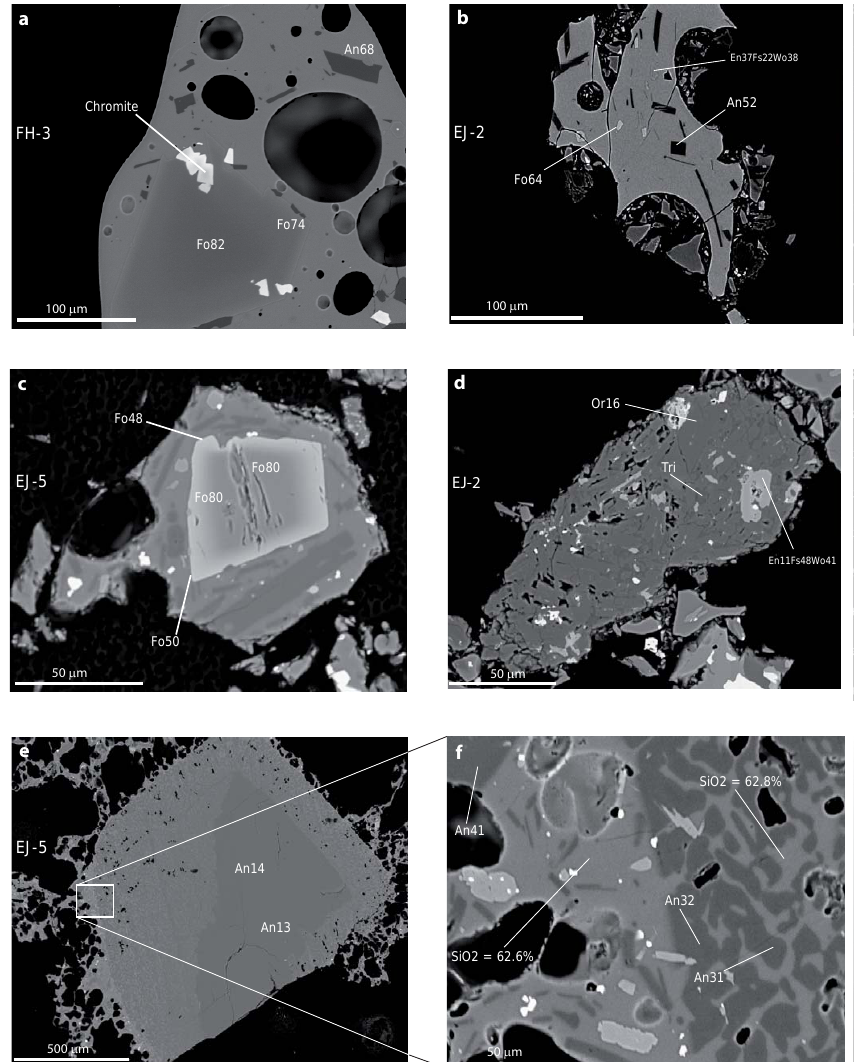
Fig. 2. Backscattered-electron images of individual tephra grains from the 2010 Eyjafjallajökull eruption: (a) basalt produced 1 April during the flank eruption at Fimmvörðuháls; (b) evolved basalt emitted together with tephra of silicic and intermediate composition during the early (17–19 April) explosive phase (note the bent plagioclase lath that grew contemporaneously with the large vesicle illustrating gas exsolution driven crystallisation); (c) cracked Mg-rich olivine-core mantled with iron-richer olivine set in partly crystalline groundmass from 5 May suggests injection of primitive basalt into the silicic magma body; (d) microsyenitic fragment composed of alkali feldspar, sodic plagioclase, ferrohedenbergite, tridymite and fluorite minerals; (e–f) destabilised oligoclase that upon melting yielded trachytic melt and calcium-richer plagioclase (see text for further discussion). Sample numbers are given at the left boundary of each image. of 0.6 % for SiO 2 , 1–2 % for TiO 2 , Al 2 O 3 and CaO, 2.2 % for FeO, and 3.3 % for Na 2 O and K 2 O, using a single set of calibration